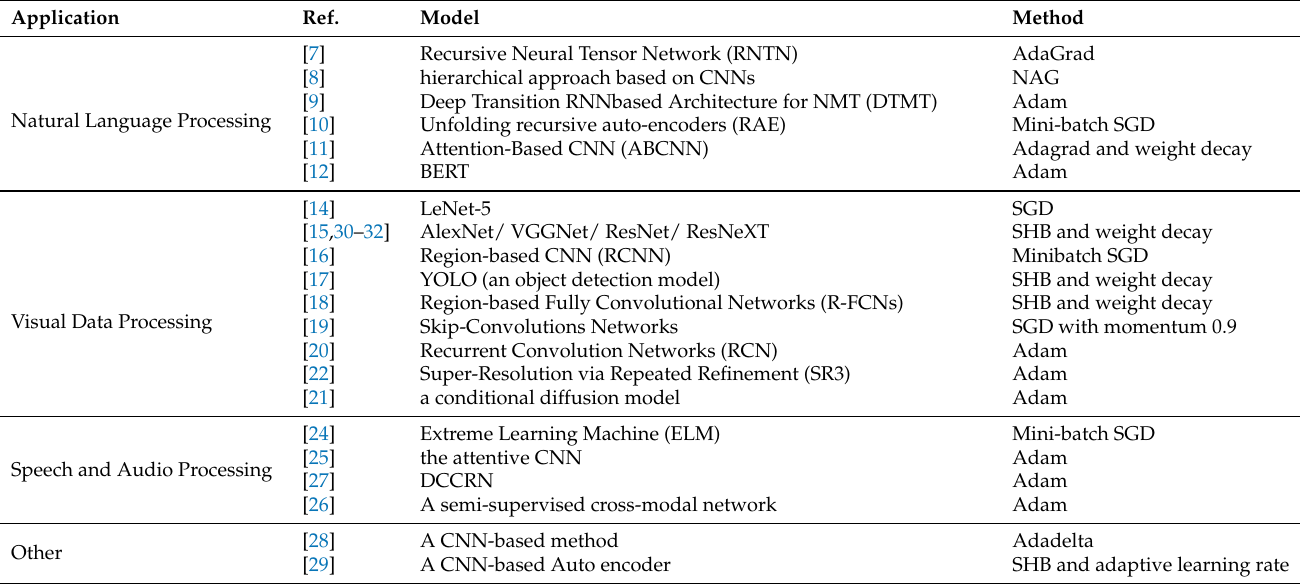
Table 1. Summary of